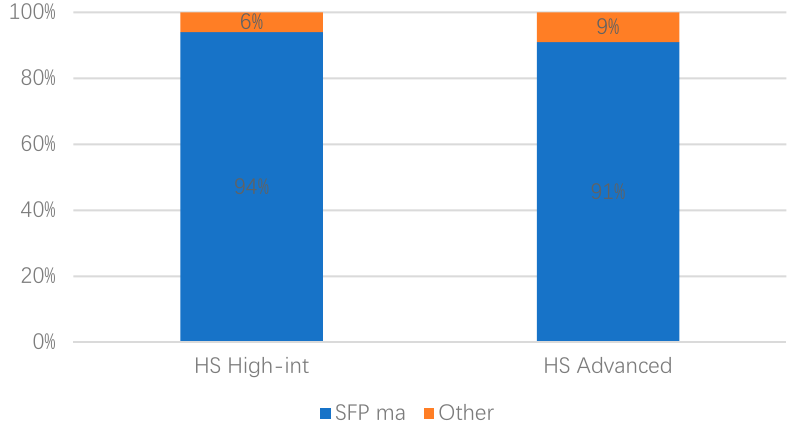
Figure 1. Percentage of ma and other errors consistently selected by heritage speakers at high-intermediate and advanced levels in confirmation seeking contexts in the DCT.